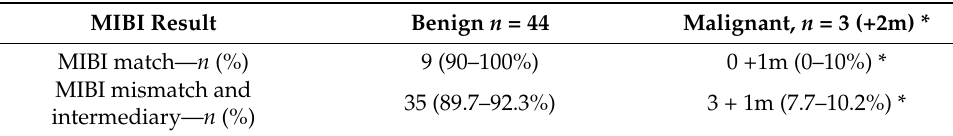
Table 3. The malignancy rates of MIBI match and non-match Bethesda III and IV